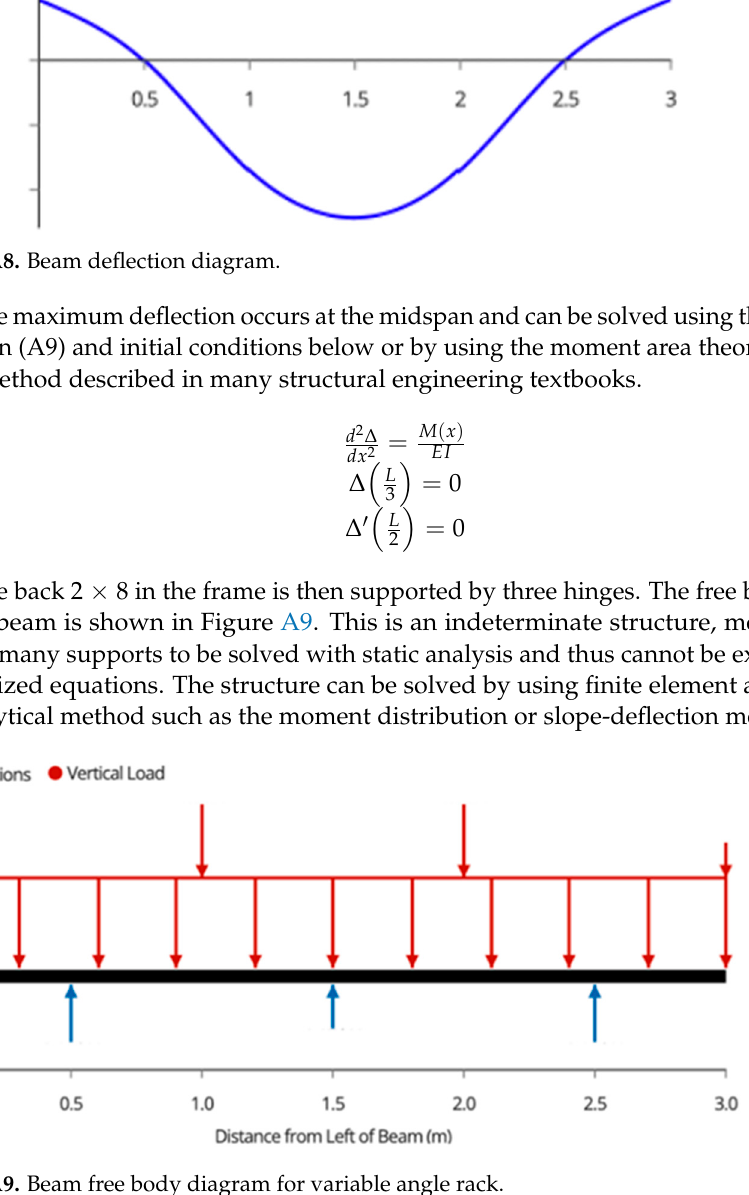
Figure A9. Beam free body diagram for variable angle rack.